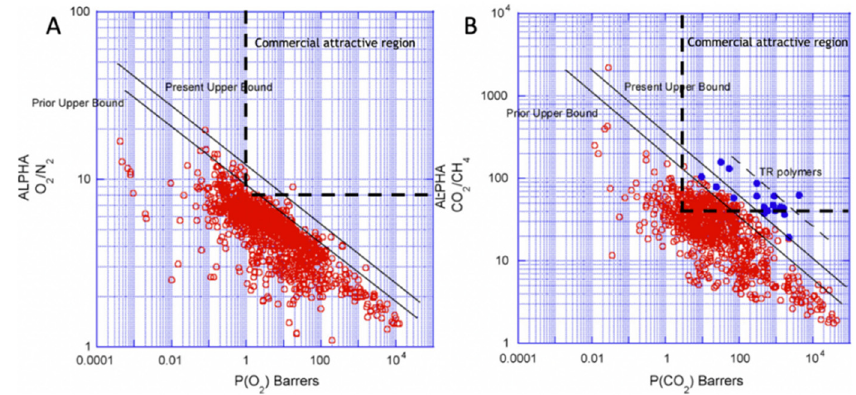
Figure 2. Robeson upper bound plots for O 2 /N 2 separation ( A ) and for CO 2 /CH 4 separation ( B ) with their industrial application attractive region, where the carbon molecular sieve membranes (CMSMs) are included (adapted with permission from [15,17]).